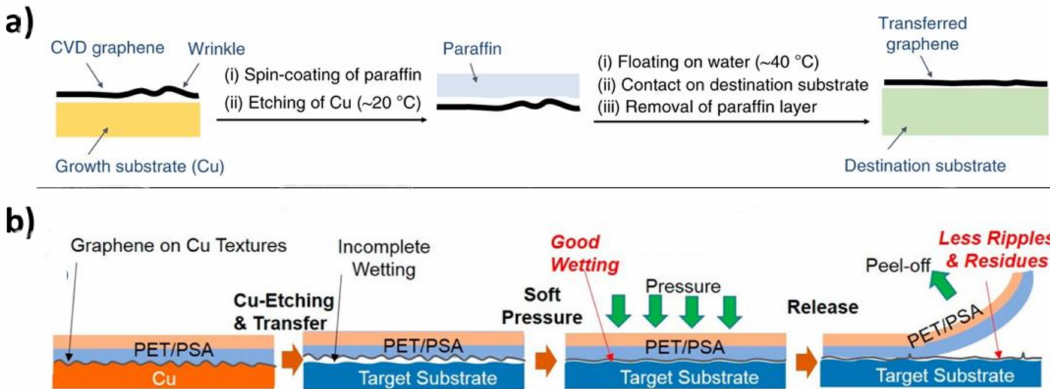
Figure 11. Using soft transfer substrates and close conformal contact with the target substrate to minimize wrinkling and ripples. ( a ) Paraffin-mediated graphene transfer. The low softening/melting point of paraffin enables conformal coating of the graphene, minimizing wrinkles. Adapted under the terms of the Creative Commons Attribution 4.0 license from Ref. [117]. Copyright 2019 Springer Nature. ( b ) Conformal contact between graphene and target substrate enabled by use of pressure sensitive adhesive and high wetting. Reprinted with permission from Ref. [122]. Copyright 2015 American Chemical